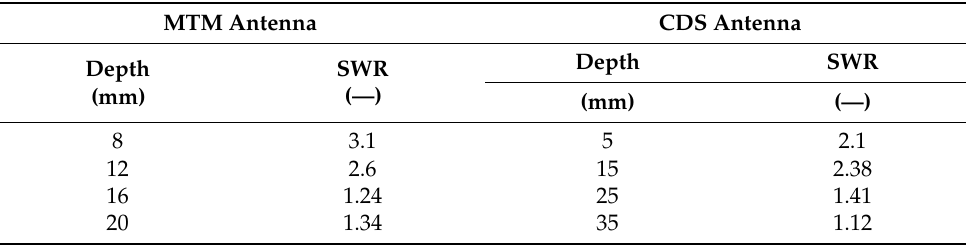
Figure 7. Experimental thermal distributions generated by each antenna through 5 min of radiation ( a ) Thermal distributions generated by the MTM antenna., ( b ) Thermal distributions generated by the CMTM antenna, ( c ) Thermal distributions generated by the DS antenna, ( d ) Thermal distributions generated by the CDS antenna through the 5 min. Table 7. Measured SWR values for different insertion depth in porcine ex vivo